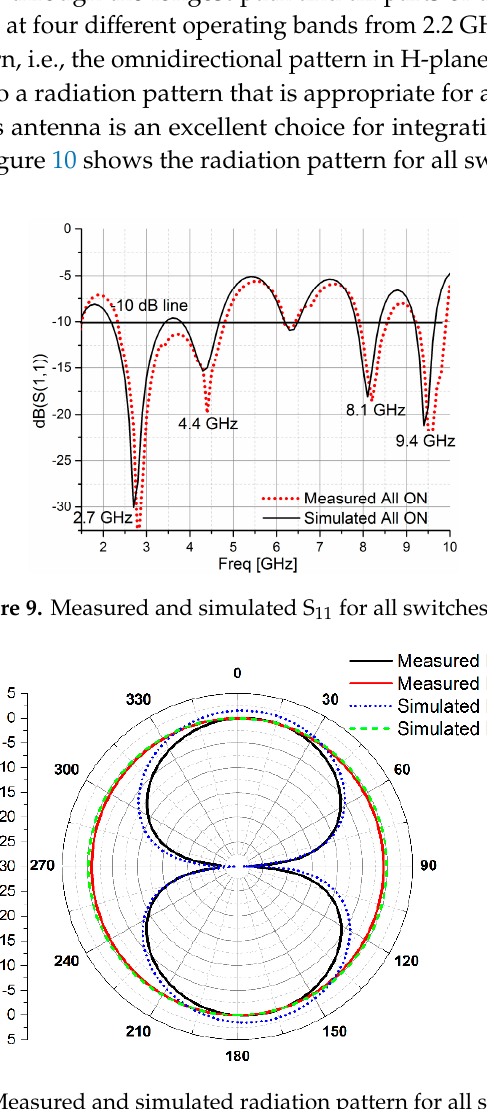
Figure 10. Measured and simulated radiation pattern for all switches ON.